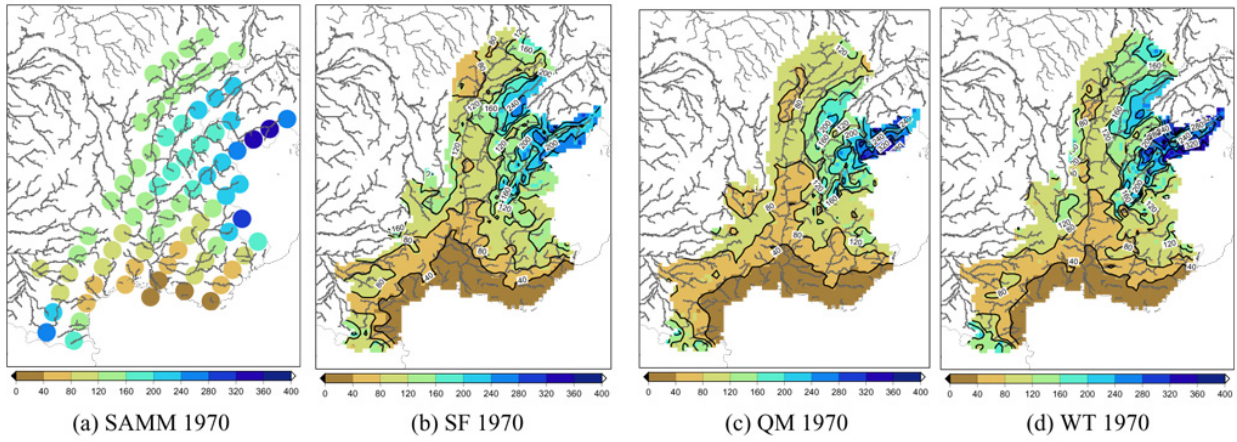
Fig. 4. PDJJA in the region of interest obtained from SAMM, SAFRAN/F and the downscaling methods for the period